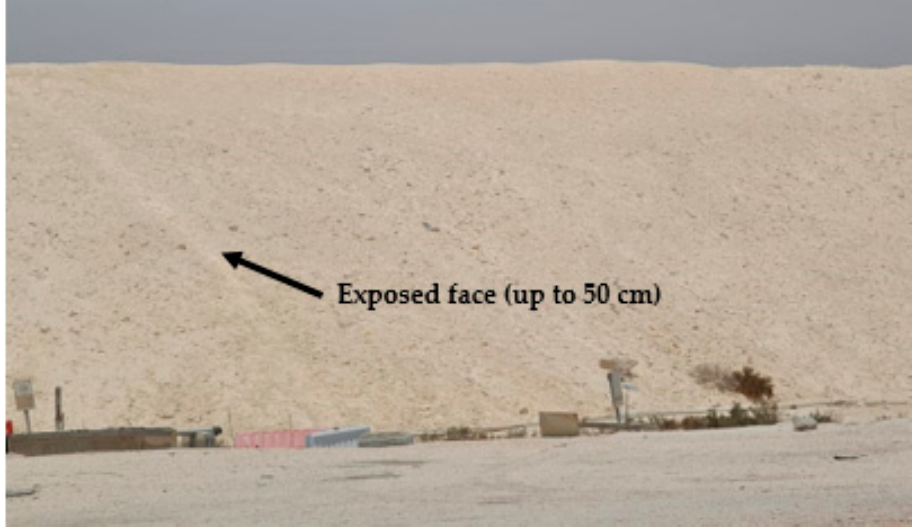
Figure 1. Gold Line TBM muck piled at MLPA Al-Riffa area.